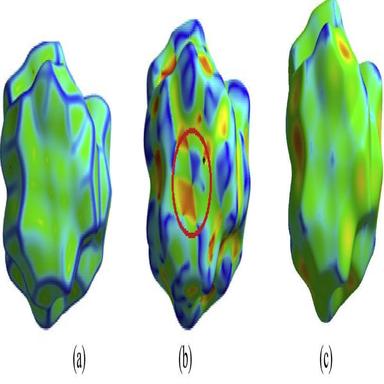
The molecule is shown with the Hirshfeld surface mapped with (a) curvedness, (b) shape index and (c) de.